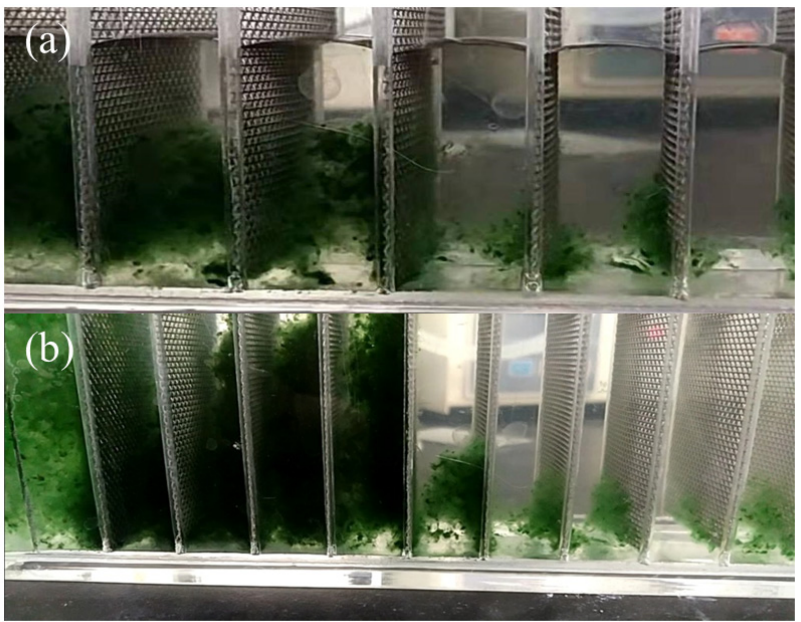
Figure 6. ( a ) Video screenshot of direct capture and removal of Anabaena by DEP (47 s); ( b ) video screenshot of direct capture and removal of Anabaena by DEP (249 s).